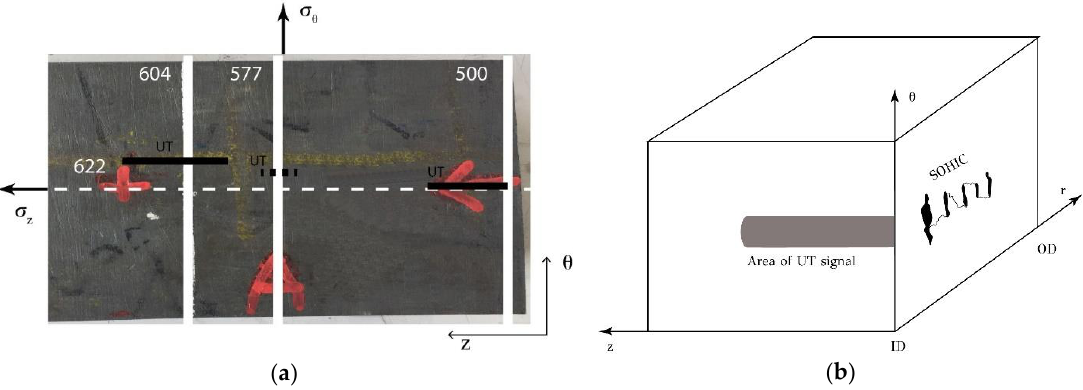
Figure 3. ( a ) Shell section for analysis (top view) indicating locations of metallographic sections and positions of UT signals; ( b ) correlation of SOHIC with UT signal (SOHIC: Stress Oriented Hydrogen Induced Cracking, ID: Inside Diameter, OD: Outside Diameter, UT: Ultrasonic